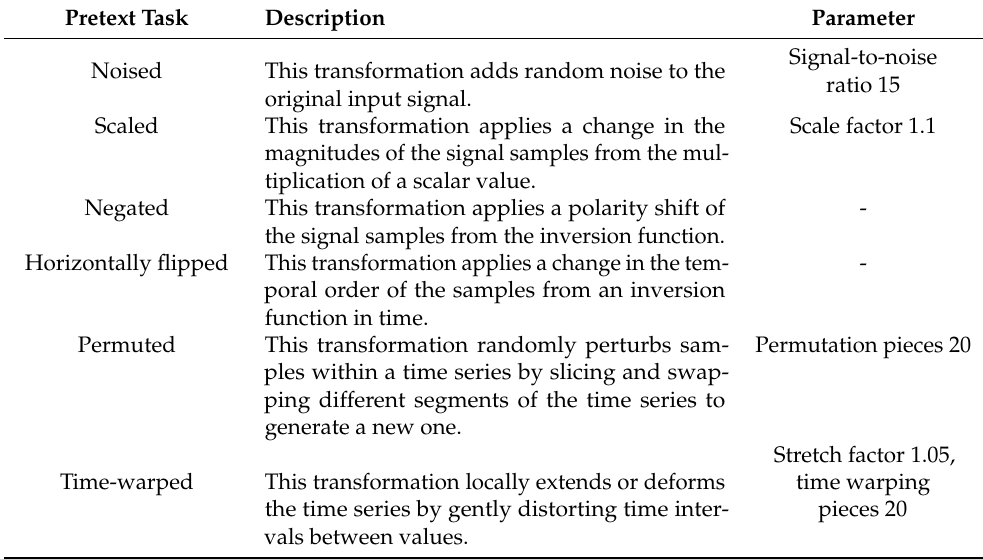
Table 1. Description of pretext tasks selected for the self-supervised model